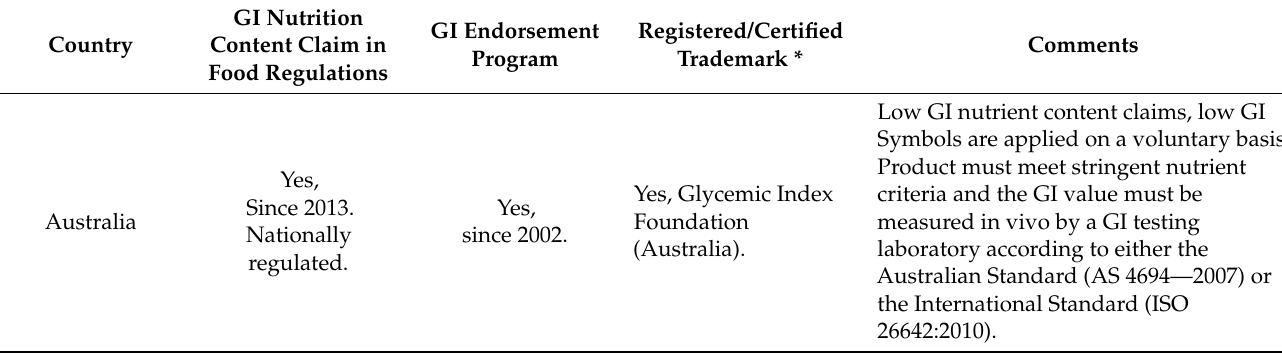
Table 5. Summary of GI claims and endorsements around the